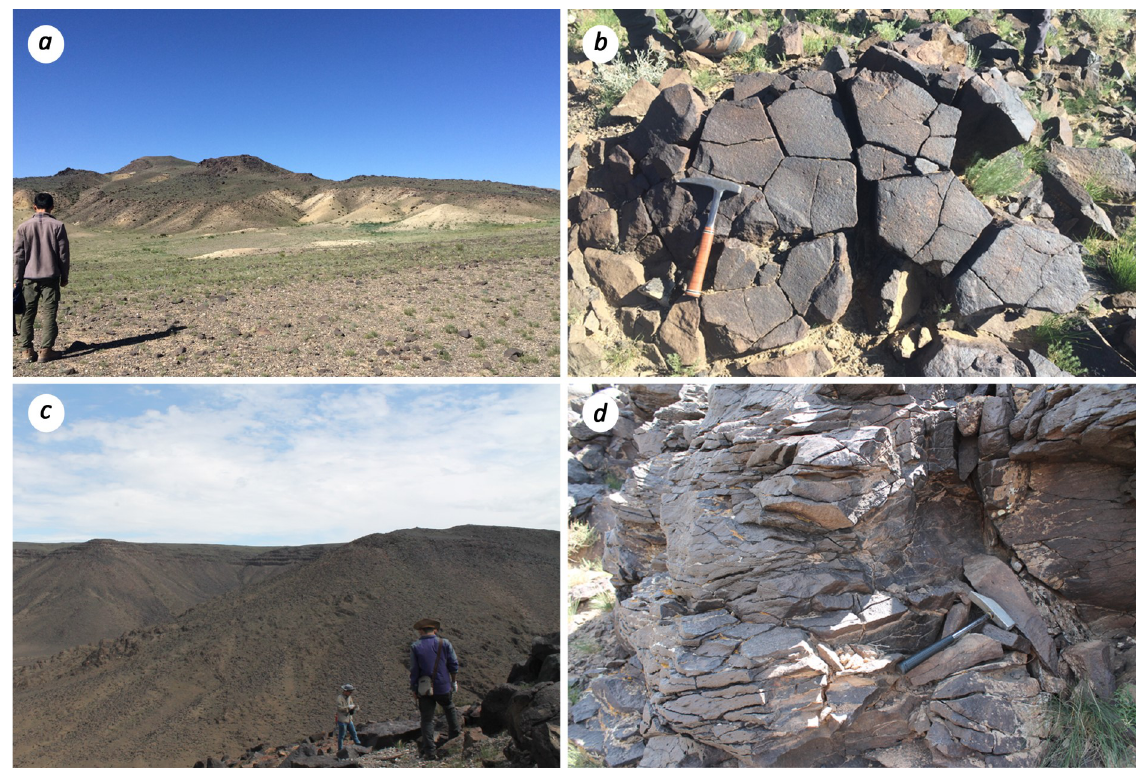
Fig. 2. Field photo (a) basaltic lava flow overlying sediments with a bedding structure in the Bayantsagaan volcanic field, (b) vertical columnar joints in lava Bayantsagaan volcanic field, (c) lava flows forming a plateau unconformably overlying the Upper Cretaceous Sainshand Fm, and (d) massive blocky surface of the basaltic lava at the Han-Uul area